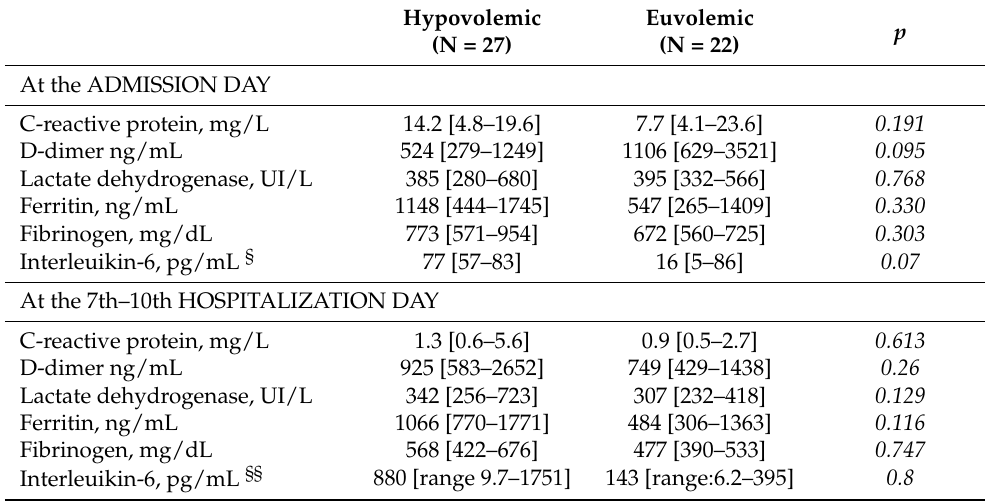
Table 2. Comparison of the inflammatory markers between hypovolemic and euvolemic at admission and at the 7th–10th hospitalization day.